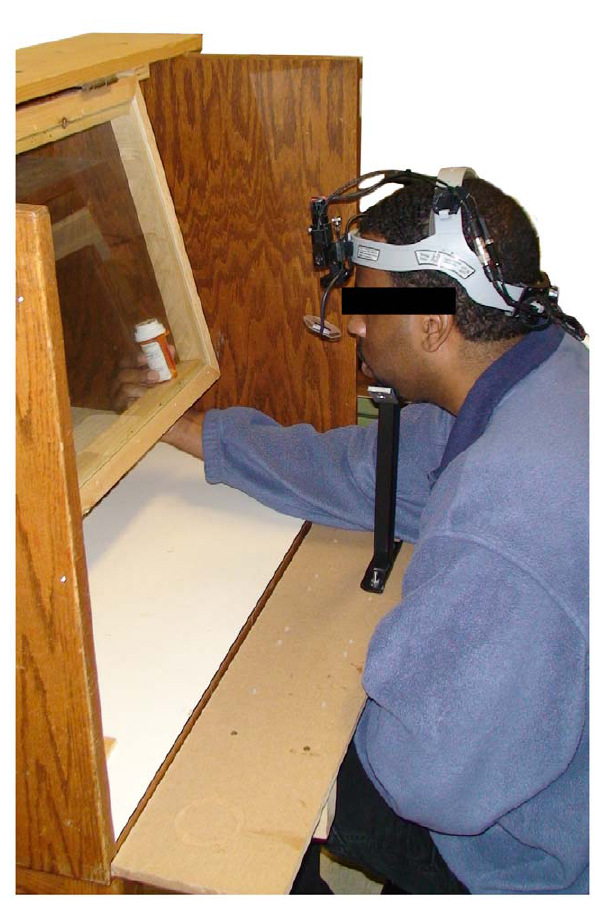
Figure 5. Experimental set up (chin rest, calibrated plane and the head-mounted optics of our ASL 501 eye tracking unit).